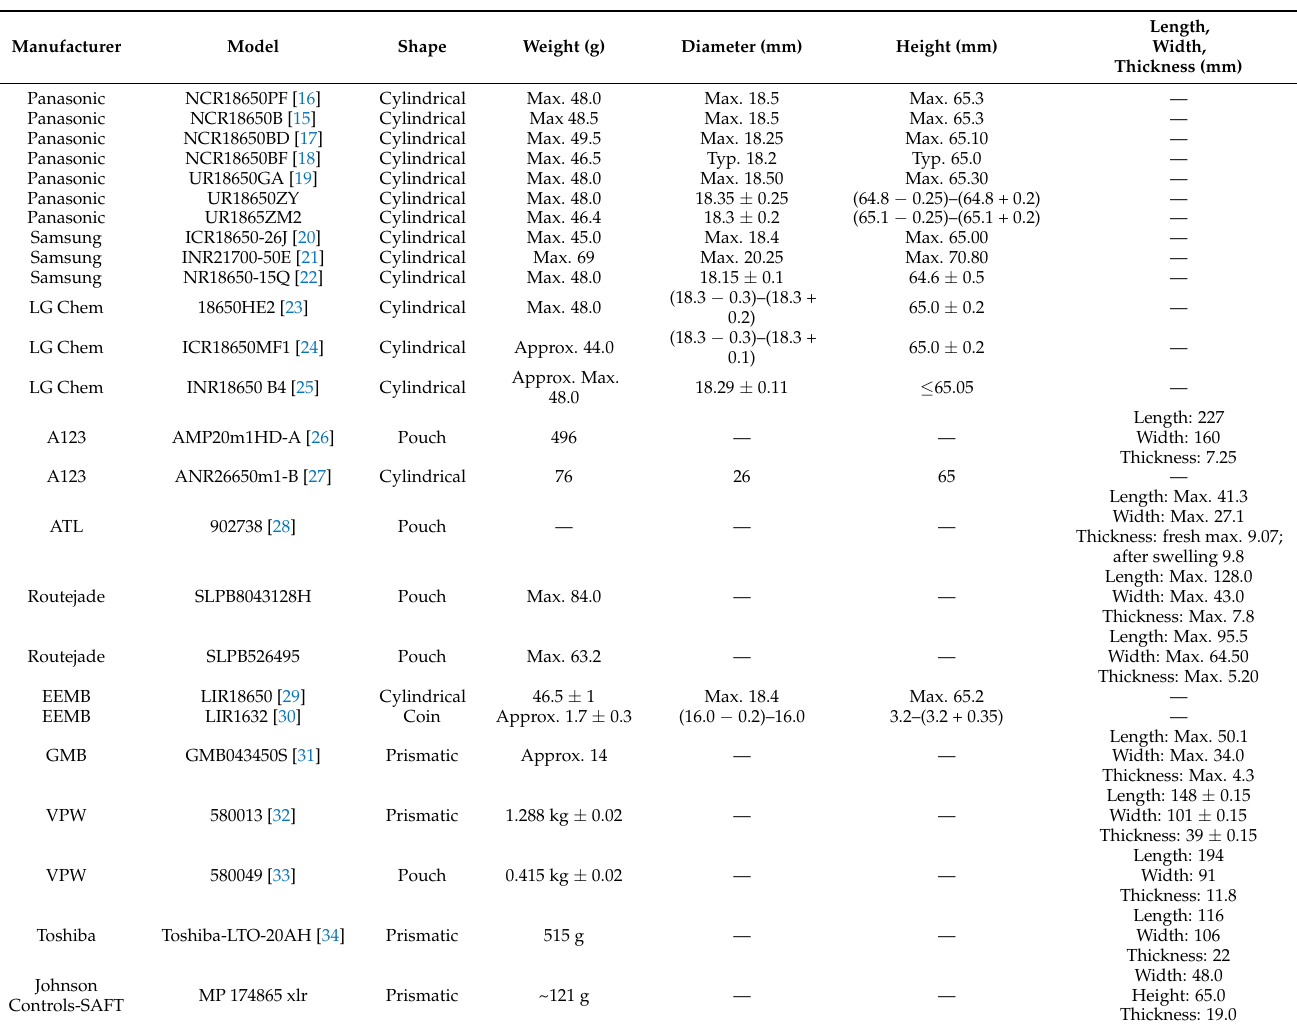
Table 1. Physical parameters used in